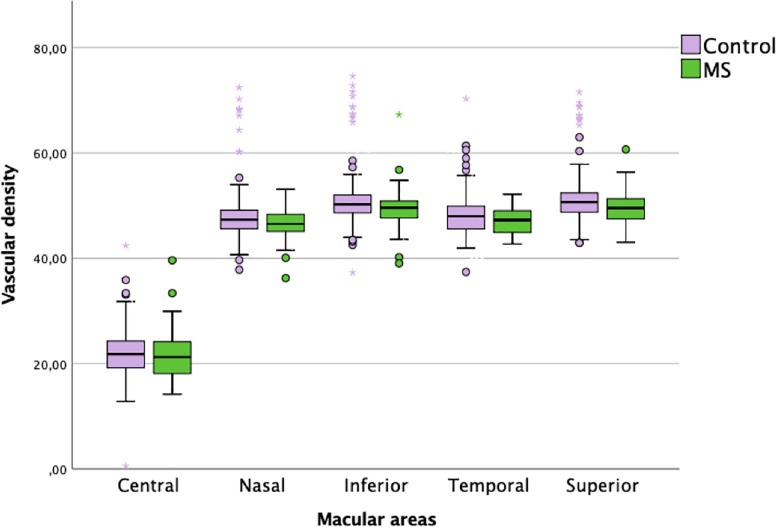
Graphic of percentage of superficial plexus macular in both groups.